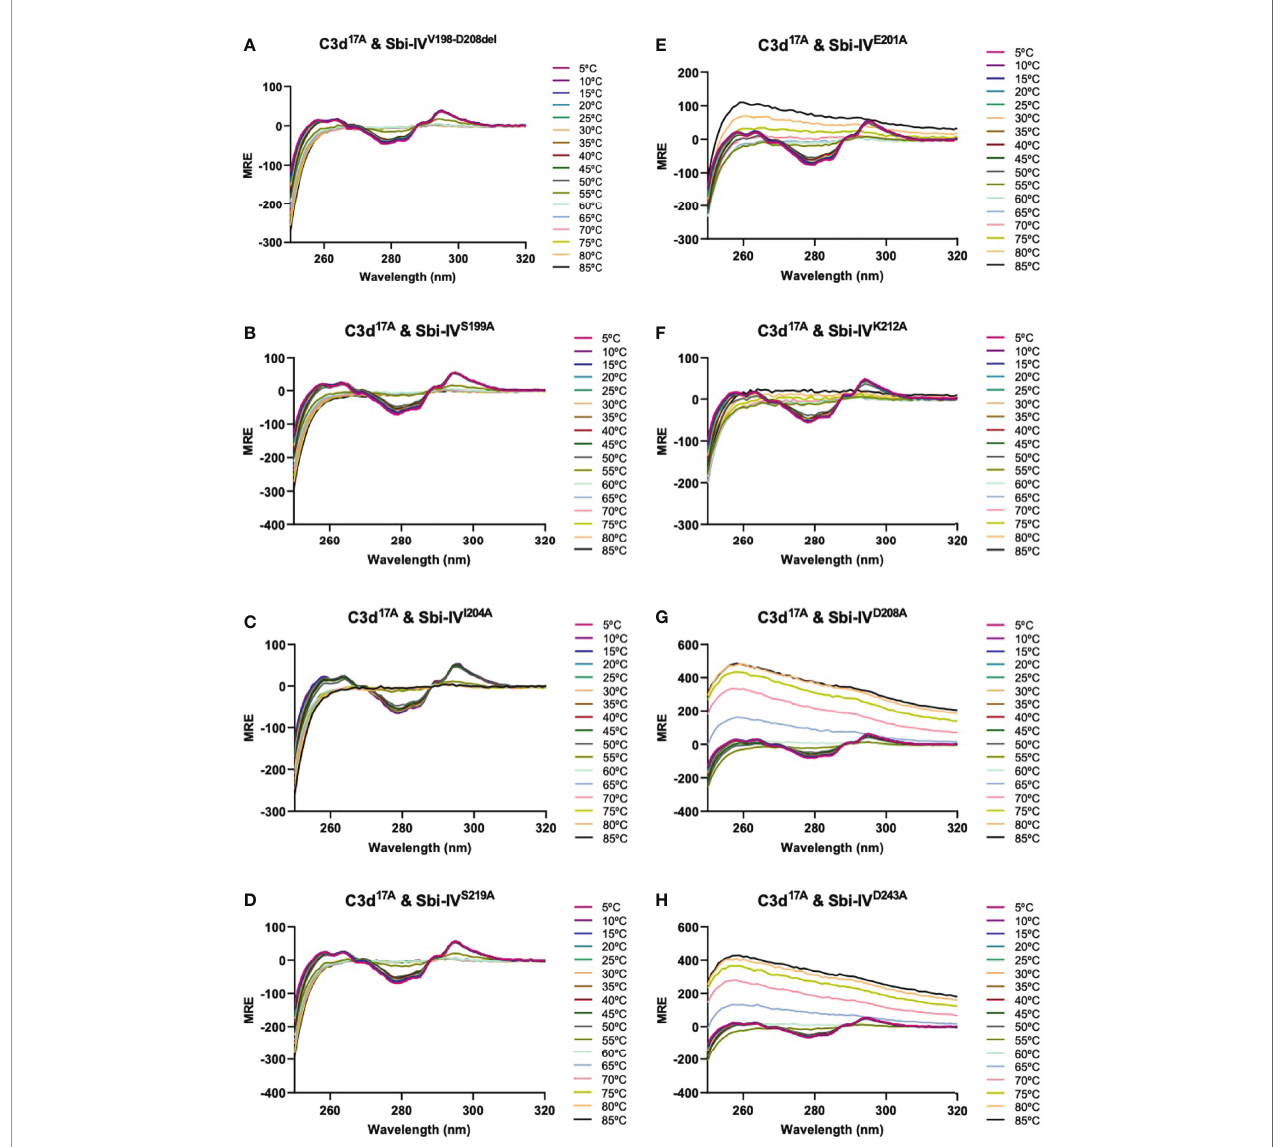
FIGURE 3 | Comparison of near-UV thermal melt circular dichroism spectroscopic studies of C3d 17A in the absence or presence of a truncated Sbi-IV mutant or Sbi-IV single mutants. (A) Whilst C3d 17A in the presence of wild-type Sbi-IV undergoes aggregation and precipitation at high temperatures ( Figure 2C ), this is not observed in the presence of truncated mutant Sbi-IV V198-D208del , lacking the N-terminal region of Sbi-IV helix a 1, and Sbi-IV single mutants S199A (B) , I204A (C) and S219 (D) . A reduced level of C3d 17A aggregation is observed in the presence of Sbi-IV single mutants E201A (E) and K212A (F) , whilst Sbi-IV single mutants D208A (G) and D243A (H) show aggregation levels comparable to those caused wild-type